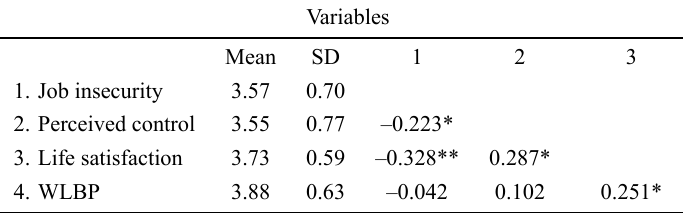
Table 3. Descriptive statistics and correlations.